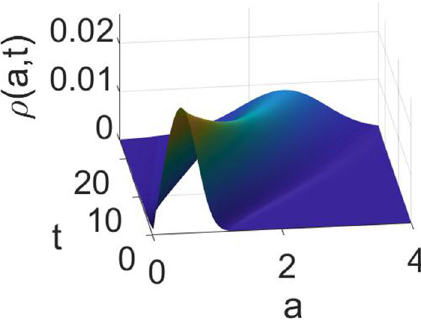
scale factor (cid:7) a (cid:2) . The horizontal and vertical axes represent (cid:7) a (cid:2) and coherence, respectively. The parameters are taken as: α = 0 . 5, V 0 = 200